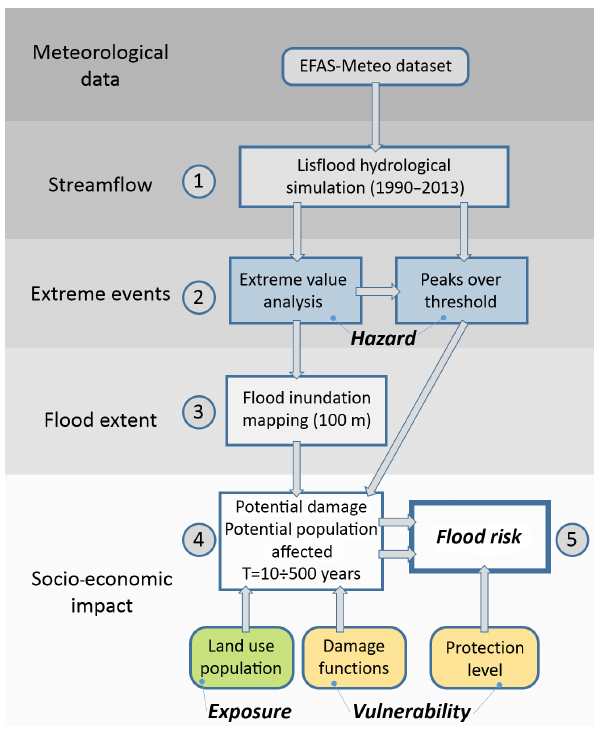
Figure 1. Schematic view of the proposed modelling framework for flood risk assessment. The three components of the risk for- mula, namely hazard, exposure and vulnerability, are highlighted with